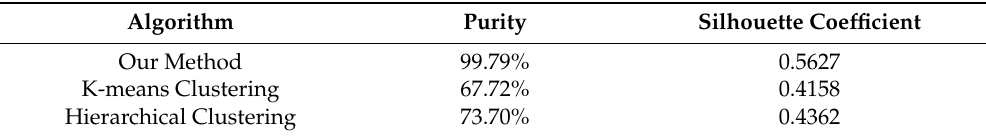
Table 3. Clustering effect of different